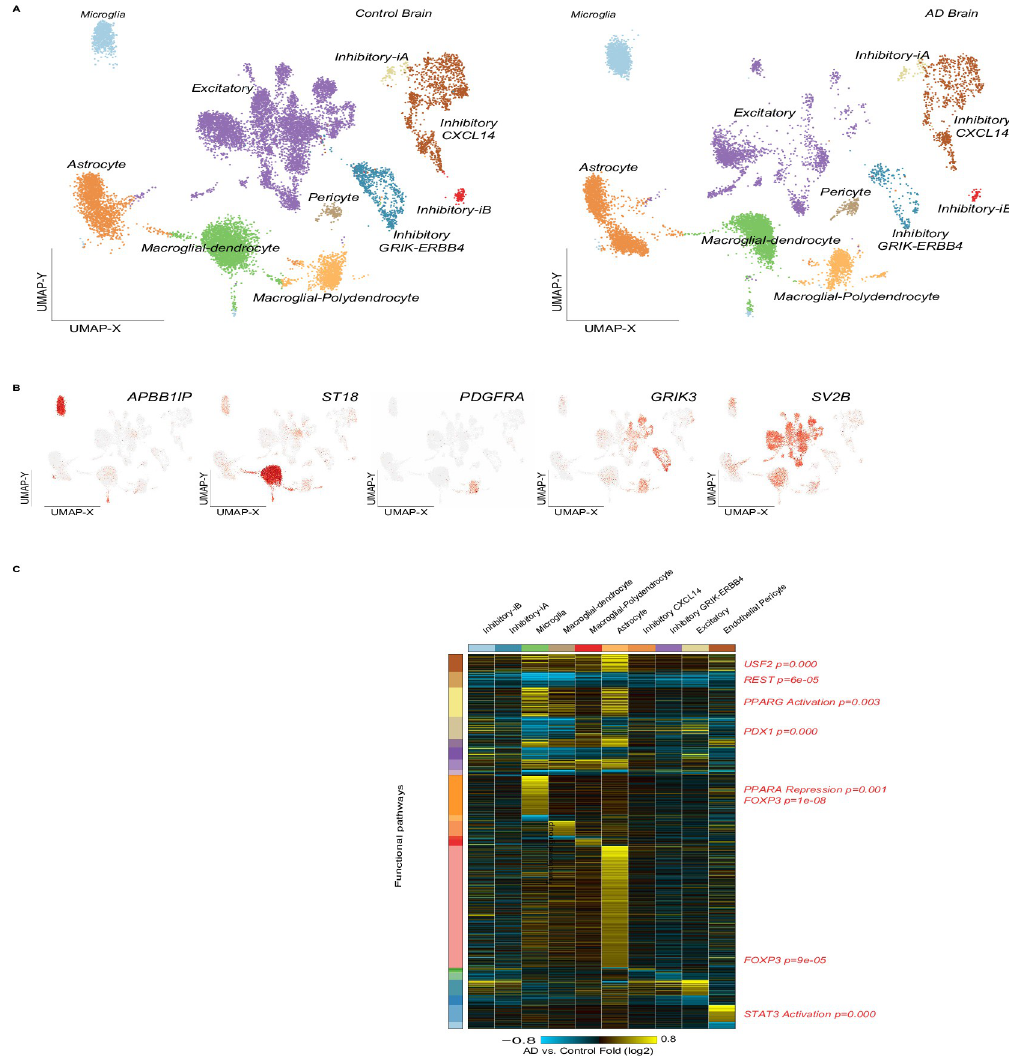
Fig 5. Microglia gene network. Gene network A) microglia. Blue: Down regulation in control samples red: Up regulation marked in red arrows–verified transcription factor (TF) targets. Grey arrow: Protein-protein interaction (PPI). Selected gene symbols are marked by larger font size. Example for such genes: HIF1A , PPARA , RB1 and RUNX1